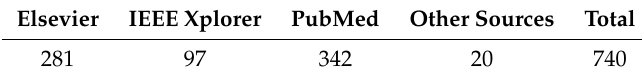
Table 2. Step 2: Relevant articles after screening titles and